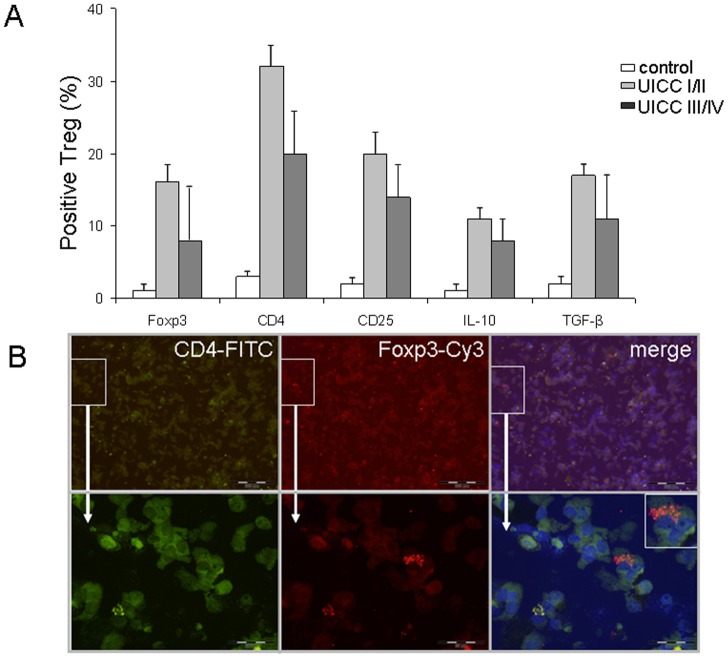
Immunohistochemical analysis of CD4+, CD25+, Foxp3+, IL-10+, and TGF-β+ expression in Treg from patients with CRC (n = 65) in early (UICC I/II) and late stage (UICC III/IV) of the disease.(A) Increased CD4+, CD25+, Foxp3+, IL-10+, and TGF-β+ expression at stage UICC I/II as compared with those at UICC III/IV. The result of the staining was expressed in percentages (%) positivity. All values were expressed as mean ± SD. All pairwise tests result in p<0.001 with three exceptions: Foxp3+, control vs. UICC III/IV, p = 0.091; IL-10+, UICC I/II vs. UICC III/IV, p = 0.021; TGF-ß+, UICC I/II vs. UICC III/IV, p = 0.020. (B) Representative example of an immunofluorescence double staining of Foxp3+ and CD4+ in Treg. Foxp3 expression was mainly observed on CD4+ Treg (arrow) (×400 magnification). FITC, green Fluoresceinisothiocyanate, Cy3, indocarbocyanin red, and DAPI 4′,6-Diamidino-2- phenylindoldihydrochlorid blue – nuclear counterstaining.